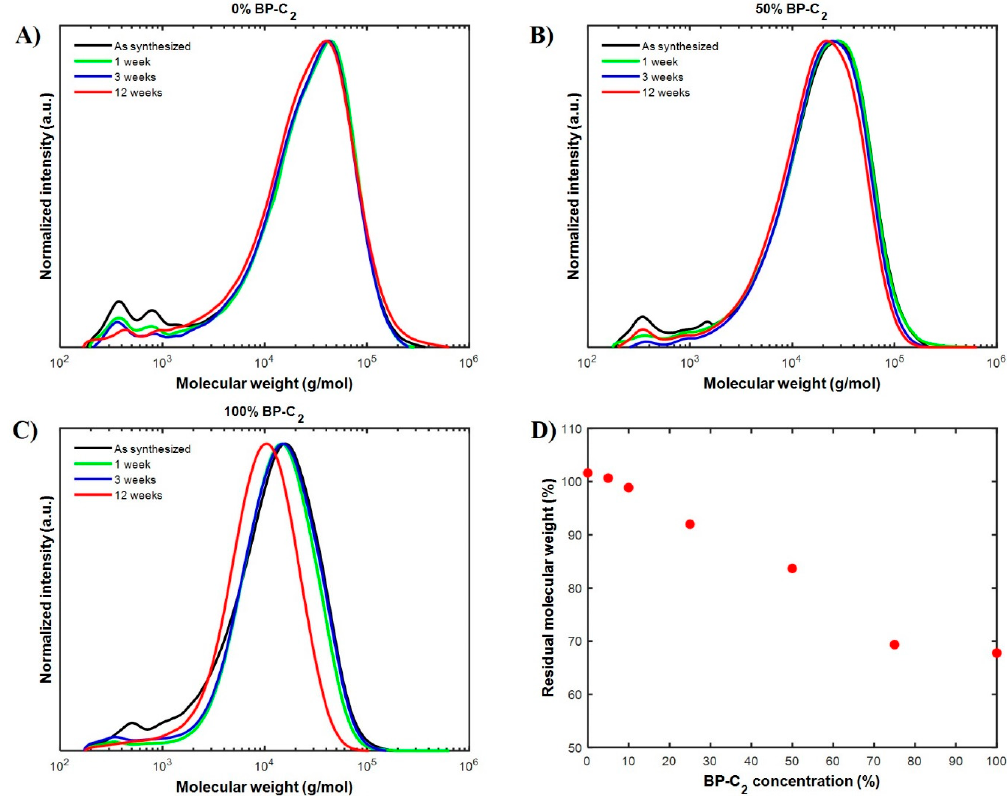
Figure 6. GPC traces of the polymers containing 0%, ( A ), 50% ( B ), and 100% ( C ) BP-C 2 as dicarboxylic acid, after immersion into demineralized water for various times. Image ( D ) depicts the change in M w for the samples immersed in demineralized water for 12 weeks.